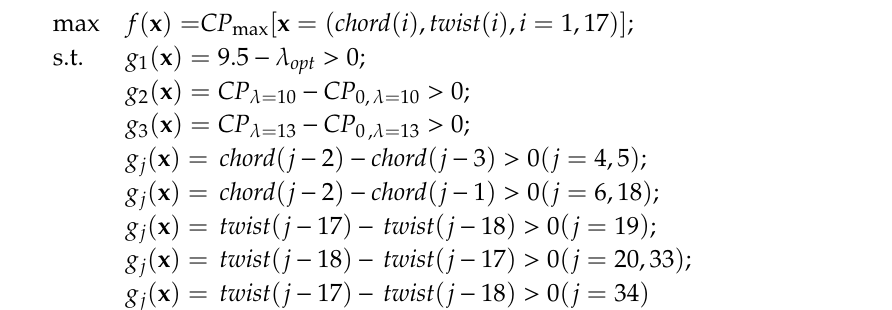
Figure 12. Comparison of pressure distributions between experimental data and present results (wind speed 20 m/s): ( a ) r/R = 0.30; ( b ) r/R = 0.63; ( c ) r/R = 0.80.